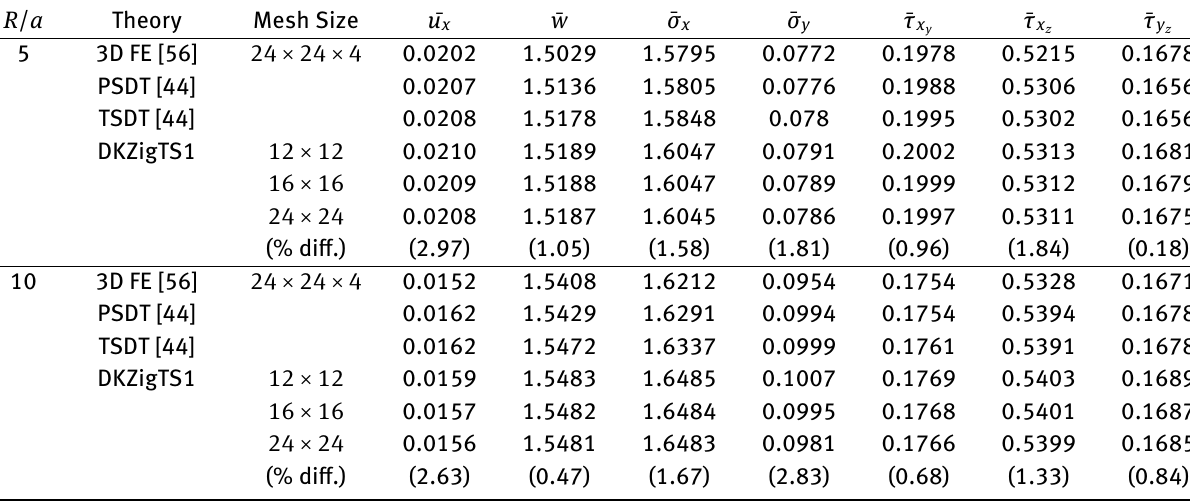
Table 15: Non-dimensionalised central deflection and stresses for an all round simply supported sandwich spherical shell panel ’G’ with b / a = 1 , h / a = 0.1 under uniformly distributed load R /